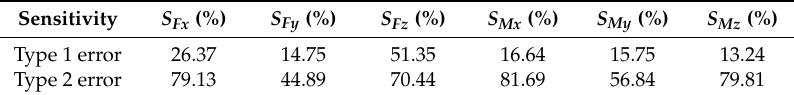
Table 5. The two type relative errors of all the component